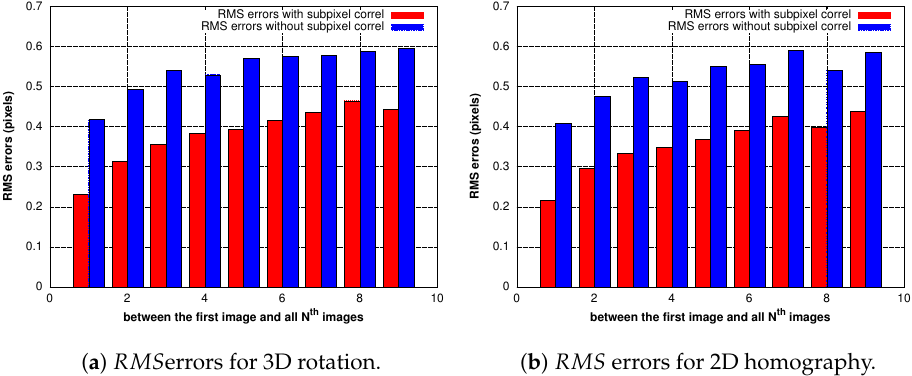
Figure 14. Residuals of the estimation of the 3D rotation and 2D homography.